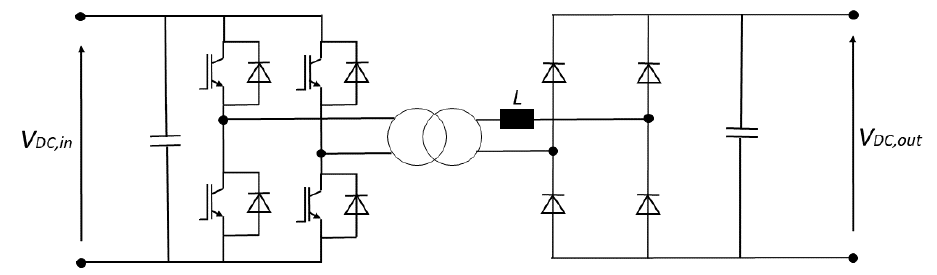
Figure 1. Single-phase single active bridge converter